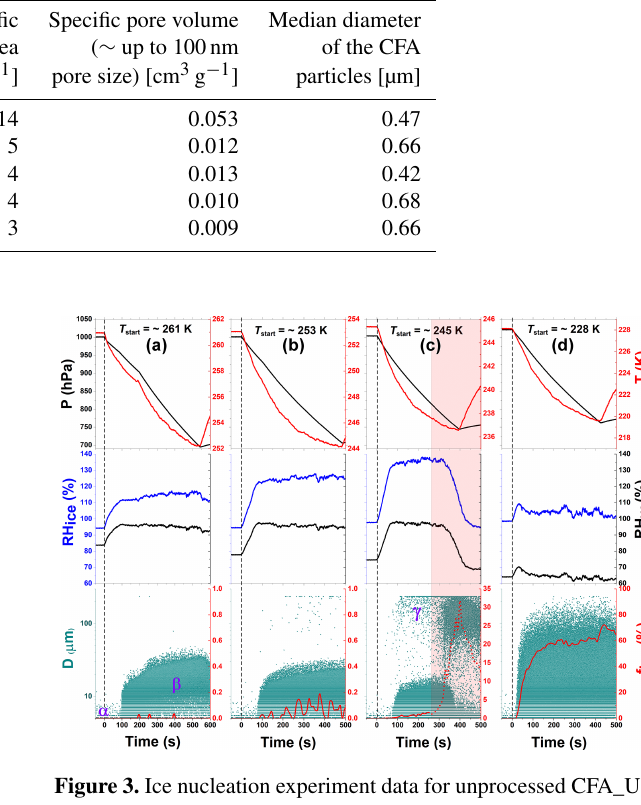
Figure 2. A schematic showing the temperature-cycling and freez- ing (TCF) process adopted in our experiments. The temperatures indicated by the grey circles represent the start temperatures ( T start ) for the ice nucleation experiments conducted after the warming of the AIDA chamber. For each CFA sample, only a subset of the in- dicated starting temperatures was chosen to conduct the expansion cooling runs (see Table 2). The start temperature of the successive experiment was individually selected based on the degree of activ- ity observed in the previous freezing experiment. The x axis denotes the overall timescale of the procedure. The homogeneous freezing line of pure water is an indication of the temperature where super- cooled water droplets were observed to freeze in previous AIDA experiments (Benz et al., 2005; Schmitt, 2014).